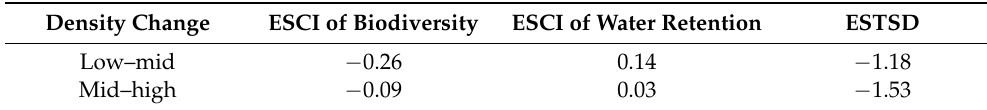
Table 5. Trade-off and synergistic relationship between the water retention capacity and biodiversity change index.